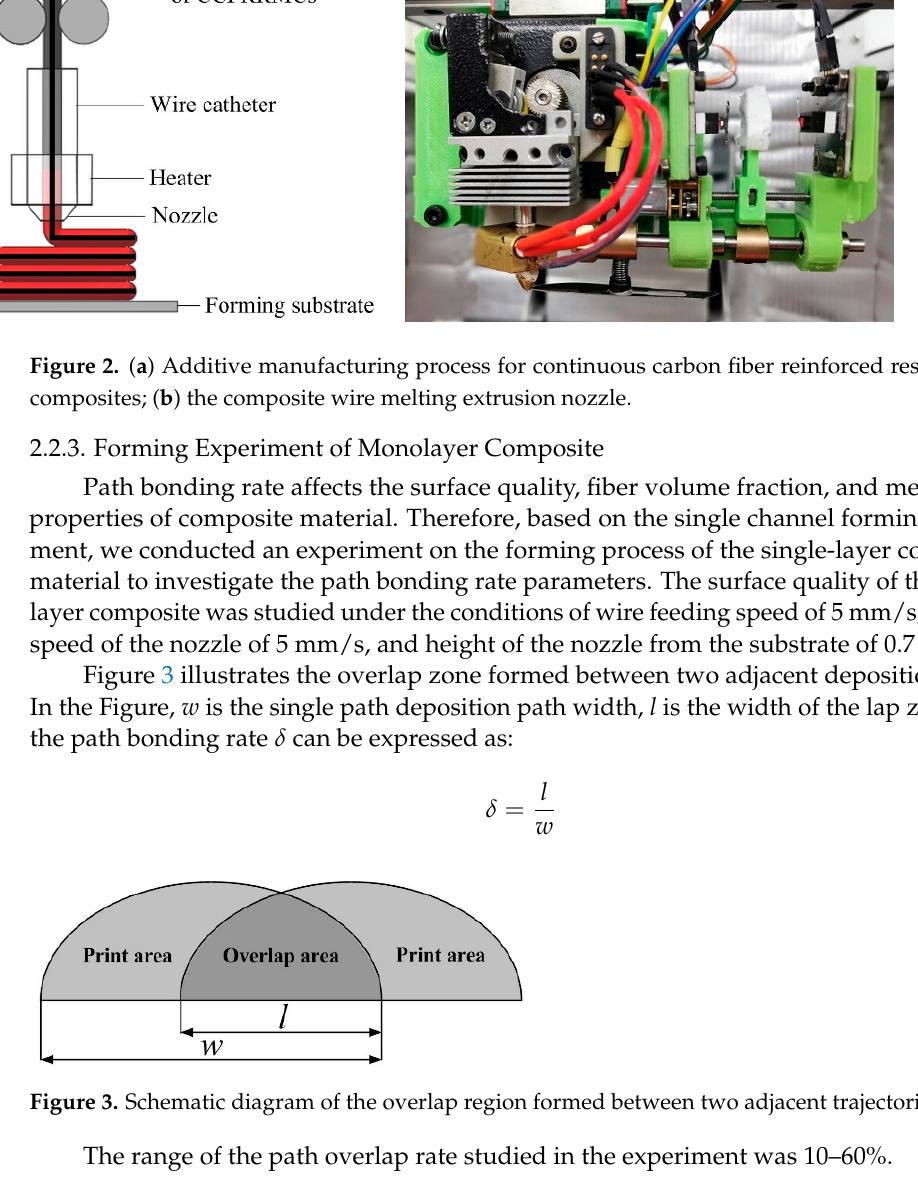
Figure 2. ( a ) Additive manufacturing process for continuous carbon fiber reinforced resin matrix composites; ( b ) the composite wire melting extrusion nozzle.